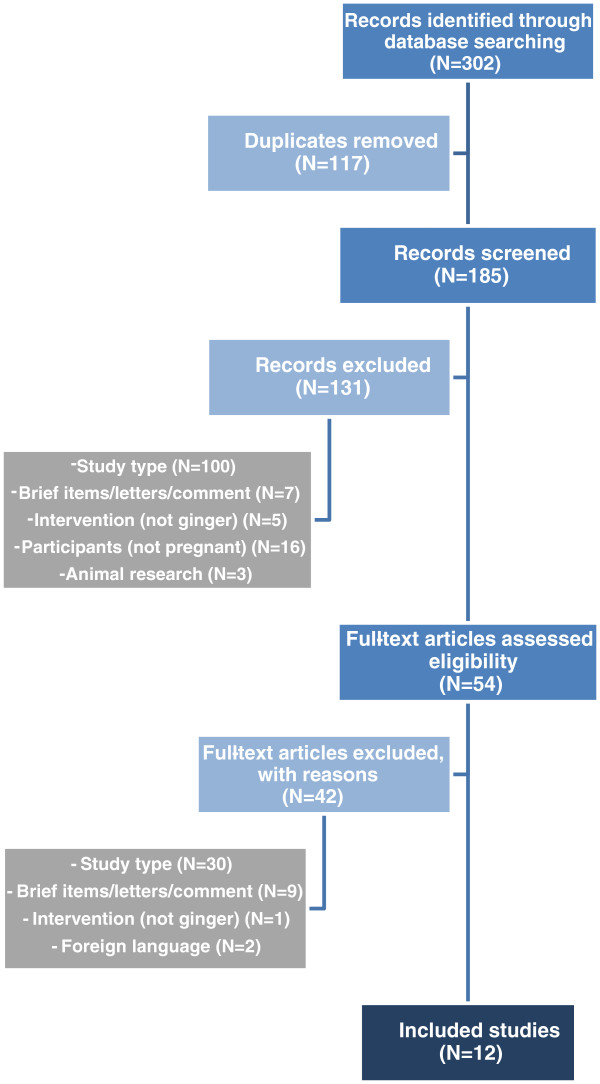
Diagrammatic representation of the process followed in the selection of studies.